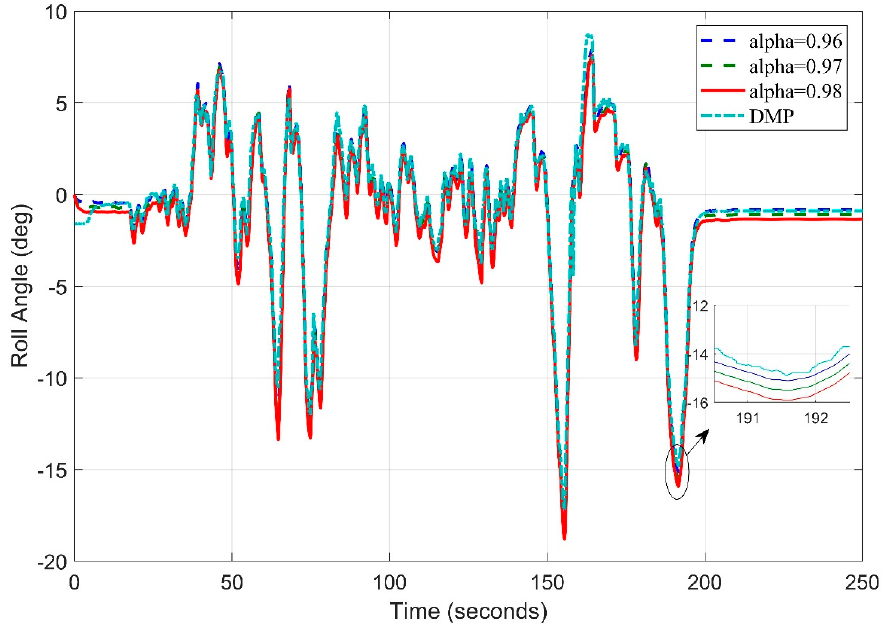
Figure 25. Real Time Roll Angle Estimate at f = 25 Hz for Complementary Filter .